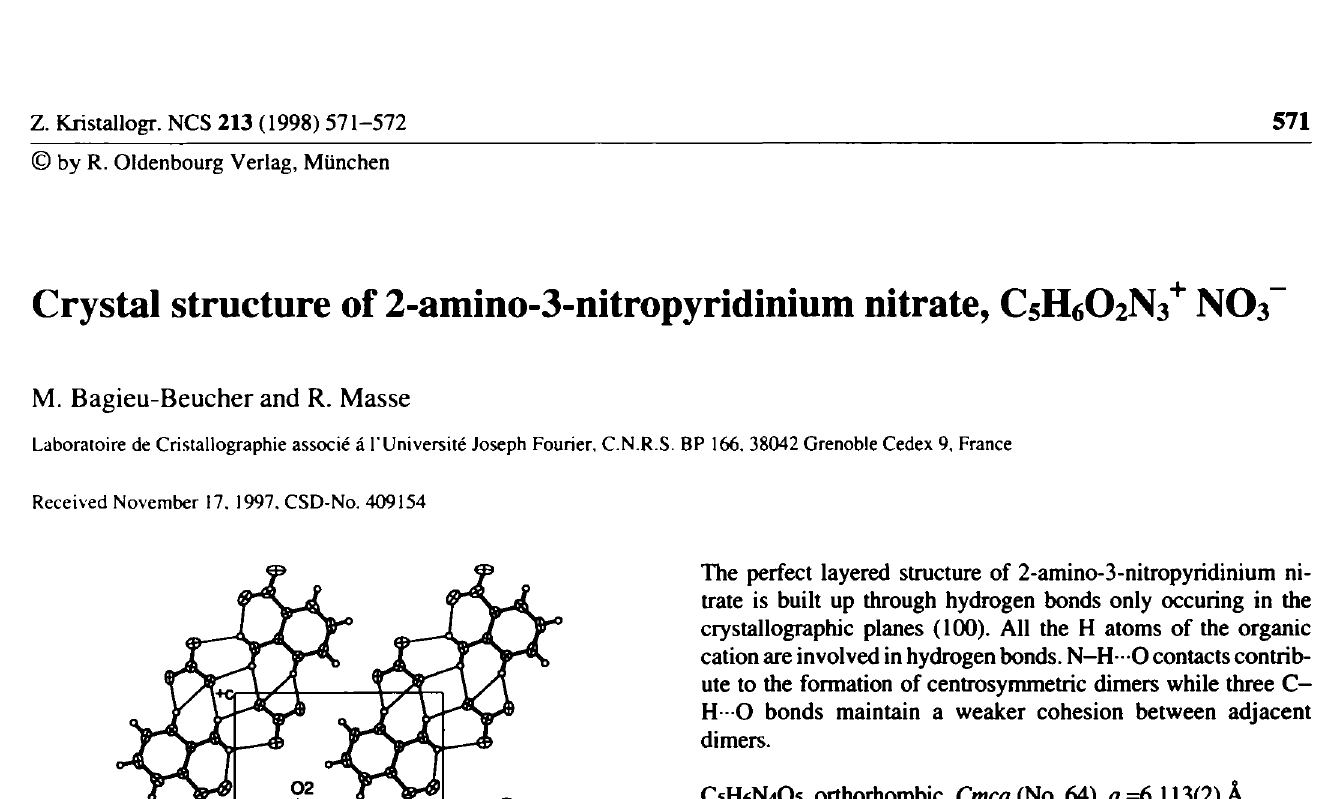
Table 1. Parameters used for the X-ray data collection Crystal: Diffiractometer: